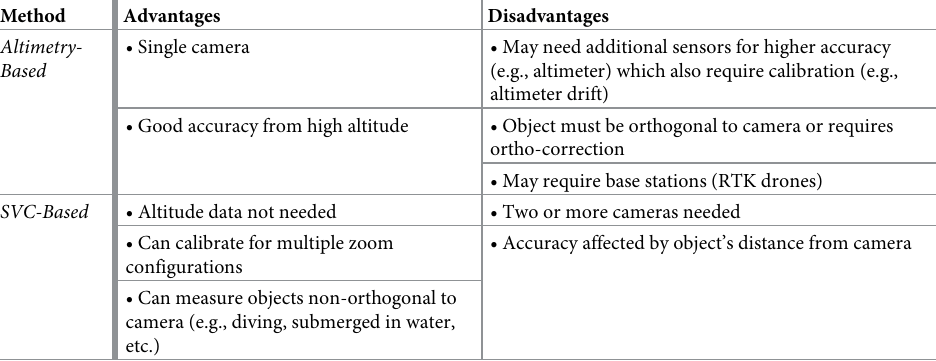
Table 1. Comparison of the altimetry and stereo-video camera methods for morphometric